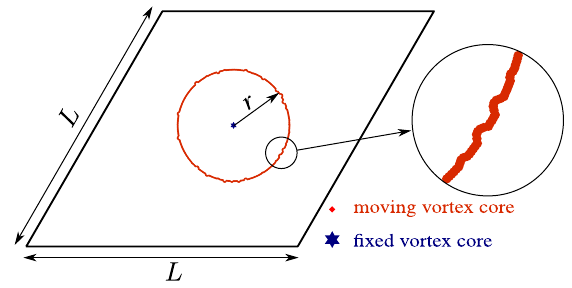
FIG. 12. A typical path in a system of L ¼ 40 with radius r ¼ 0 : 2 L . The discretization points are distributed at uniform angular coordinates, but the radial coordinate is shifted to maintain the minimal distance of 0.25 (in units of lattice spacing) from the lattice